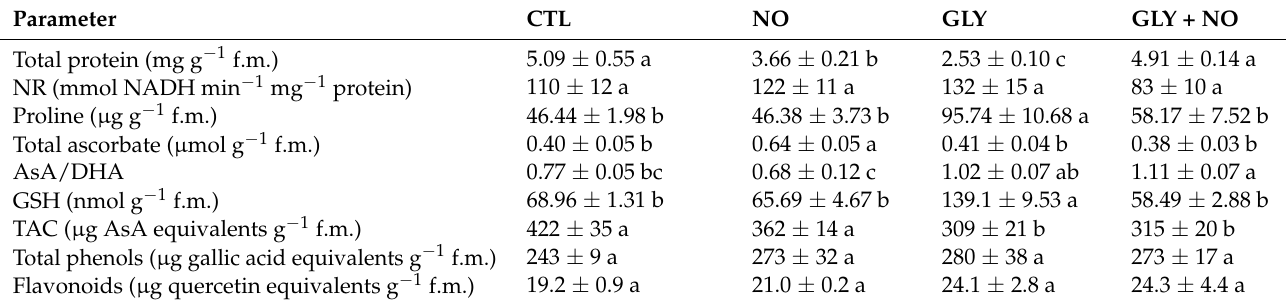
Table 2. Biochemical parameters (total protein, nitrate reductase (NR) activity, proline, total ascorbate, ascor- bate:dehydroascorbate (AsA/DHA) ratio, glutathione (GSH), total antioxidant capacity (TAC), total phenols and flavonoids) of roots of Solanum lycopersicum L. cv. Micro-Tom grown for 28 days in an artificial soil contaminated by GLY (10 mg kg − 1 ) and/or foliar sprayed with SNP (200 µ M). CTL—control plants, grown in the absence of GLY and foliar sprayed with dH 2 O once a week; NO—plants grown in the absence of GLY and foliar sprayed with SNP once a week; GLY—plants grown in the presence of GLY; GLY + NO—plants grown in the presence of GLY and weekly sprayed with SNP. Results are presented as mean ± standard deviation (SD) and result from the evaluation of at least three experimental replicates ( n ≥ 3). Different letters indicate significant differences between groups (CTL, NO, GLY and GLY + NO) at p ≤ 0.05, according to the one-way ANOVA followed by Tukey’s post hoc